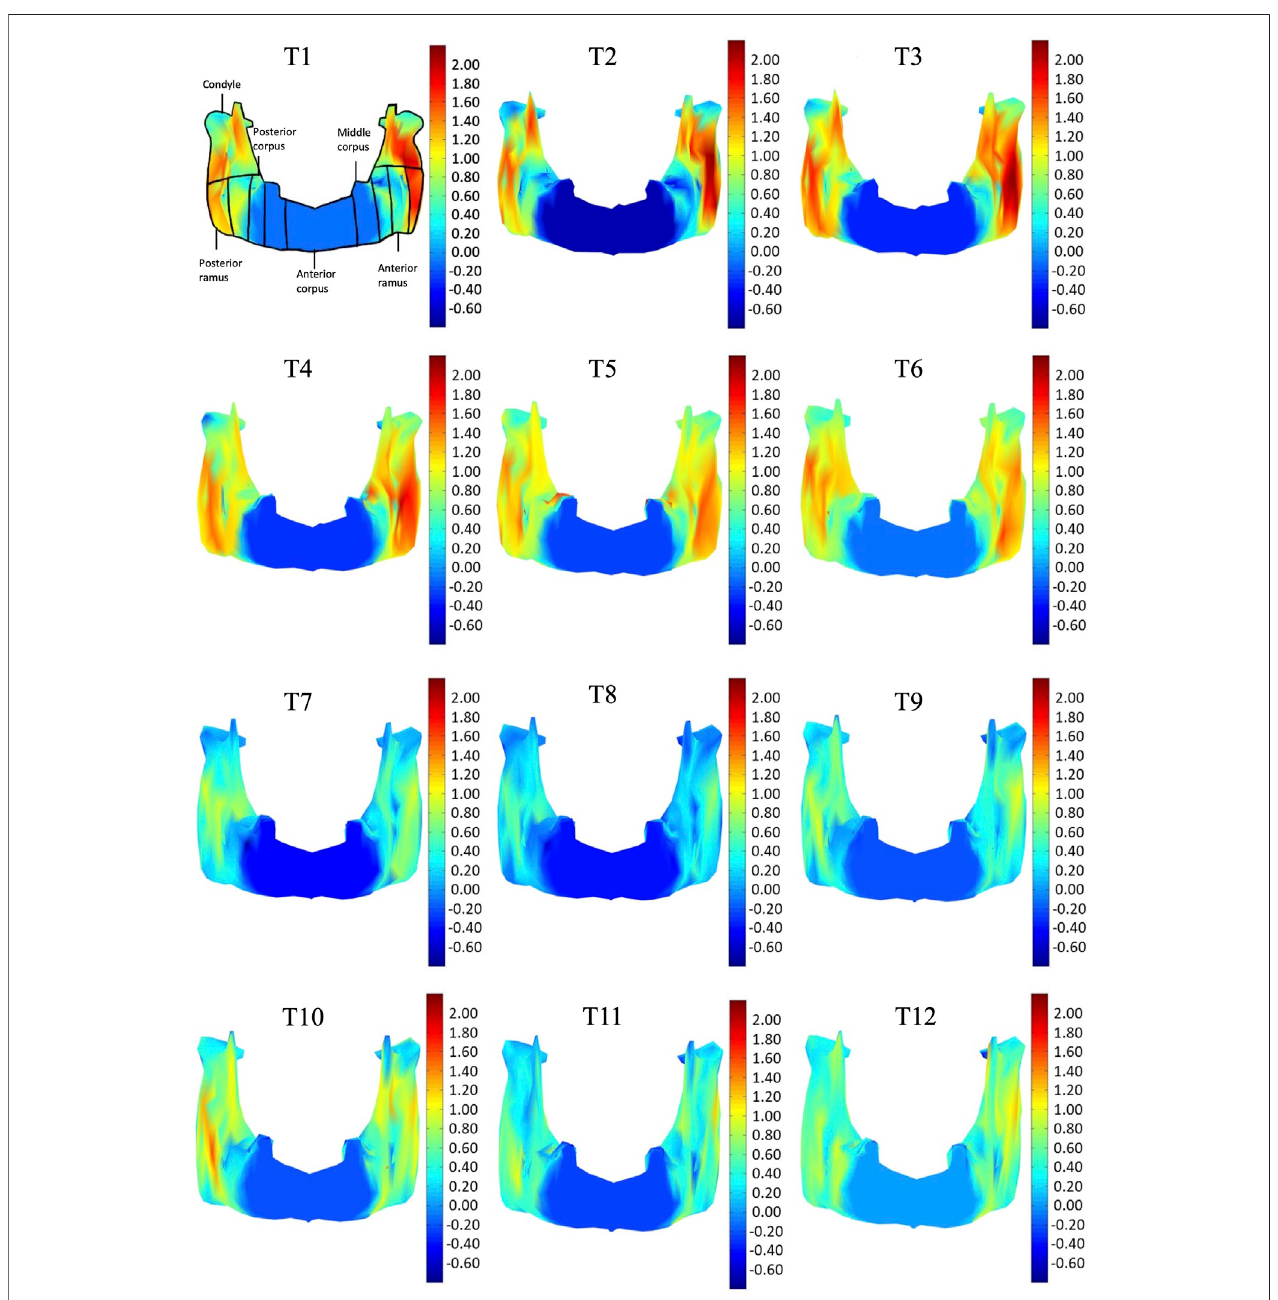
FIGURE 6 | Frontal view of the mandible of a typical subject with monthly rates of morphological changes over the mandibular surface as color maps from T1 to T12. The models were scaled to a similar size for better visualization. (unit: %/month).